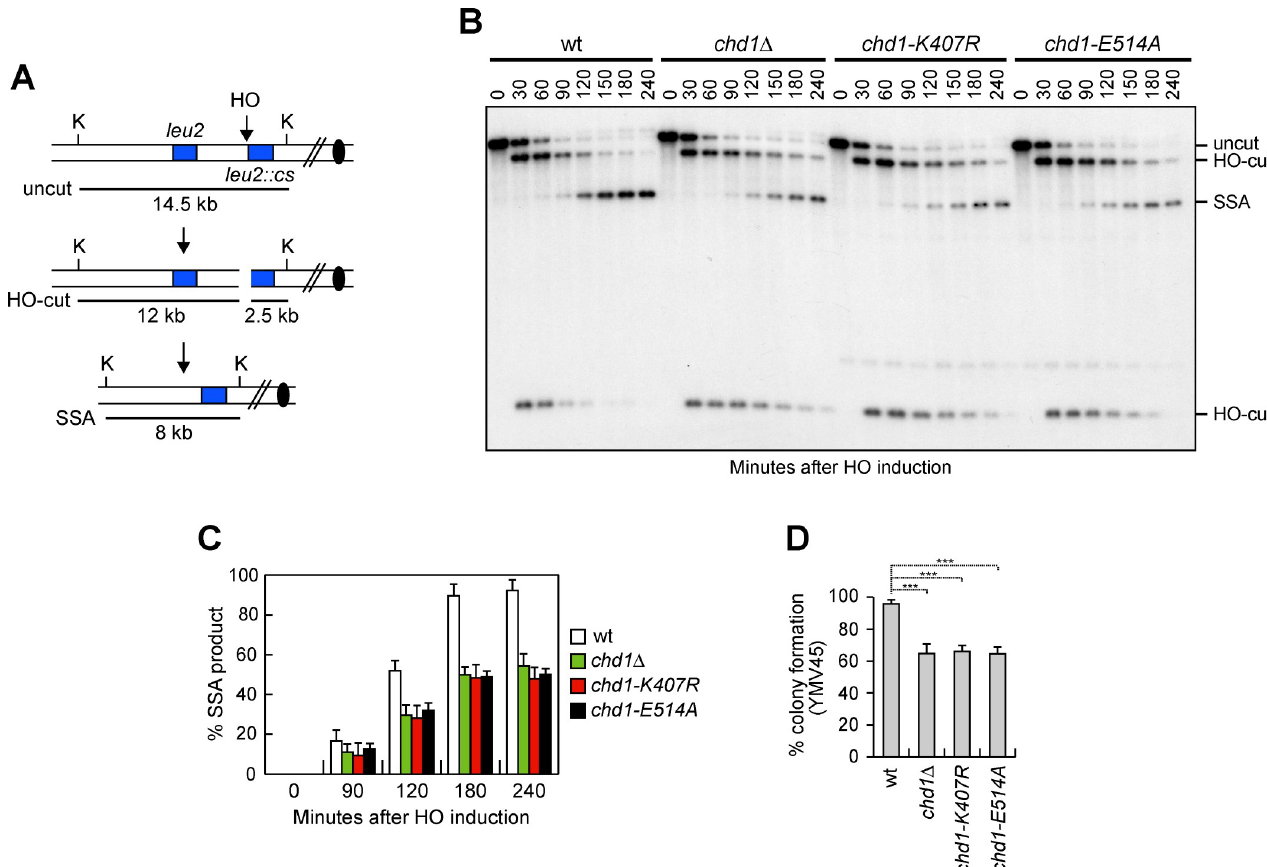
Fig 4. Chd1 dysfunction reduces DSB repair by SSA. (A) Schematic representation of the YMV45 chromosome III region, where a unique HO-cut site is adjacent to the leu2 ::cs sequence, which is 4.6 kb apart from the homologous leu2 sequence. HO-induced DSB results in generation of 12 kb and 2.5 kb DNA fragments (HO-cut) that can be detected by Southern blot analysis with a LEU2 probe of KpnI-digested genomic DNA. DSB repair by SSA generates a product of 8 kb (SSA). K, KpnI. (B) Exponentially growing YEPR cell cultures of YMV45 derivative strains were transferred to YEPRG. Southern blot analysis of KpnI- digested genomic DNA. (C) Densitometric analysis of the SSA product. Plotted values are the mean values of three independent experiments as in panel B, with error bars denoting s.d. (D) Percentage of colony formation on YEPRG plates relatives to colony formation on YEPD plates. The reported values are the mean values of three independent experiments, with error bars denoting s.d. ��� P < 0.005, t-